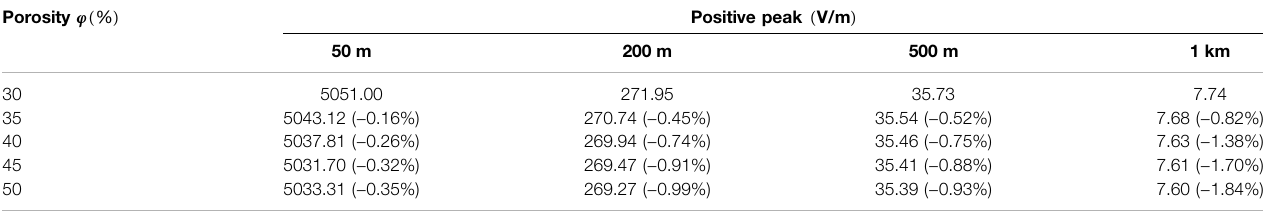
TABLE 6 | Positive peak values of the horizontal electric fi eld (Er) for different porosities φ at different distances d (cid:2) 50m, 200m, 500m, and 1 km from the lightning channel; θ (cid:2) 15%; h (cid:2) 10m; the change rate of the values at different porosities relative to that at the porosity of 30% is marked in parentheses. Porosity φ ( % )